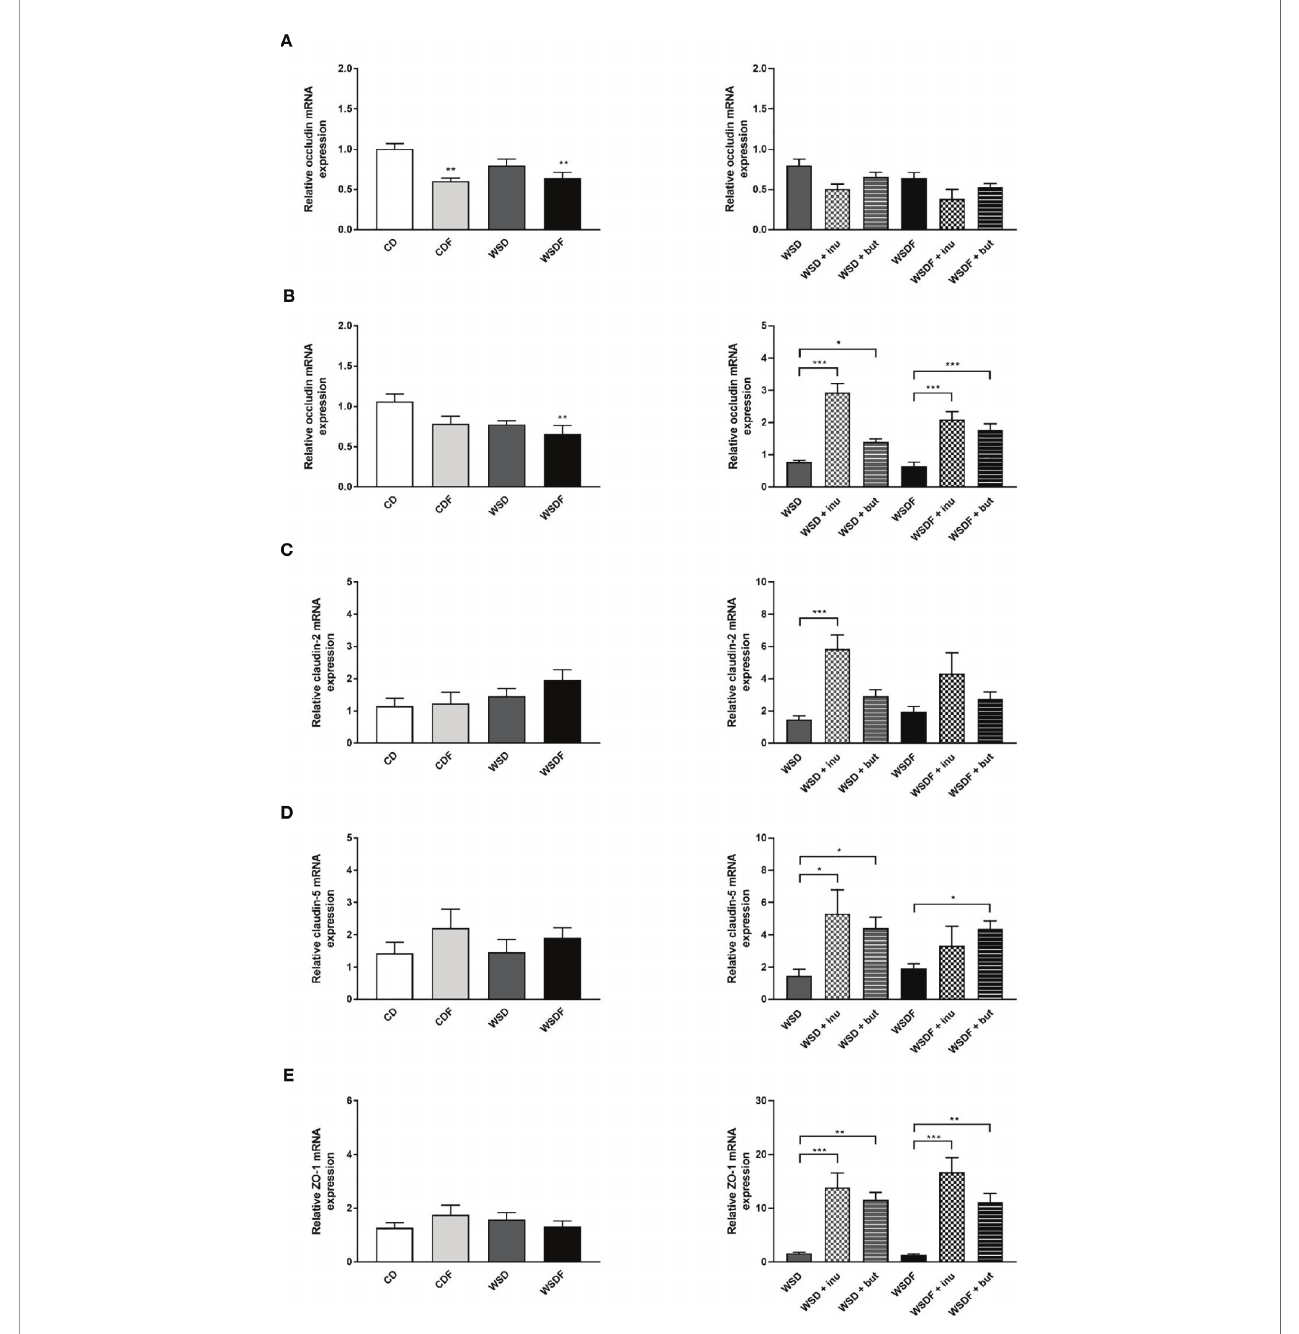
FIGURE 6 | Effect ofinulin andsodium butyrate supplementation on intestinal tight junctions. C57BL/6 mice fed different diets as described in Figure 1 are shown. Relative mRNA expression level of occludin inthe ileum (A) andin the colon (B) , claudin-2 (C), claudin-5 (D) and ZO-1 (E) inthe colon determined byquantitative RT-PCR.Data are presentedas means+/-standard error of themean (SEM)(n= 6 – 8).Statistical analysiswas performedby one-way ANOVA with Dunnett´sor Sidak´spost-test or byKruskal- Wallis-test for non-parametricdata with a Dunn ’ s post-test. Signi fi cant differences are indicated as *p-value < 0.05; **p-value < 0.01; ***p-value <